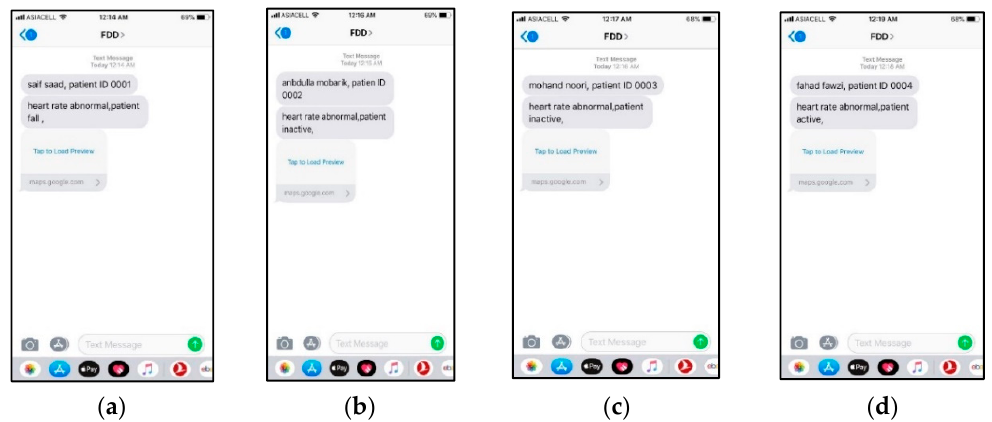
Figure 16. Messages received with details from four different volunteers on the smartphone of the caregivers; ( a ) Message 1, ( b ) Message 2, ( c ) Message 3, and ( d ) Message 4.